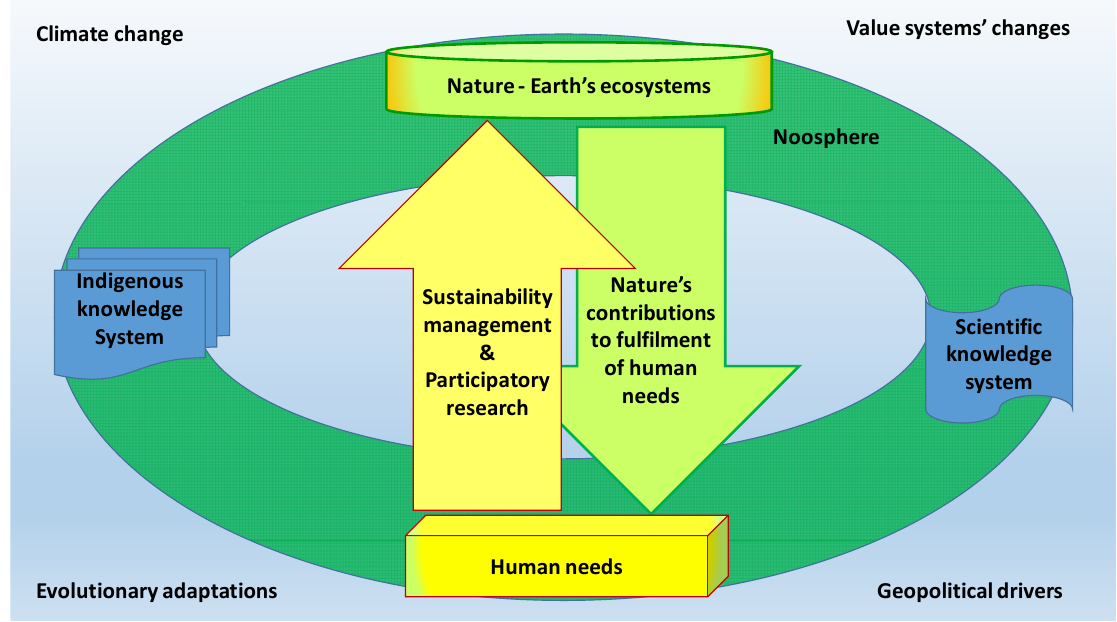
Figure 1. Traditional and scientific knowledge concerning sustainability management as a part of the Noosphere.